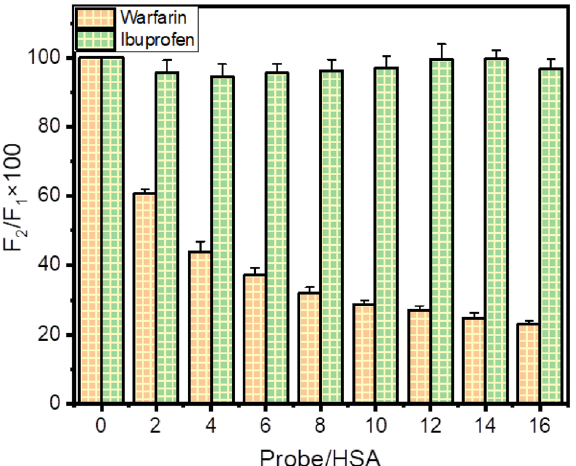
Figure 4. Graphical representation of site marker displacement assay for the location of binding site of trans - resveratrol on HSA at 298.15 K and pH7.4, warfarin, and ibuprofen site markers were used for subdomain IIA and subdomain IIIA specific binding, respectively. At the level of 0.05 (p < 0.05), the data is significant. Error bar represents the standard deviation value (mean ± SD).